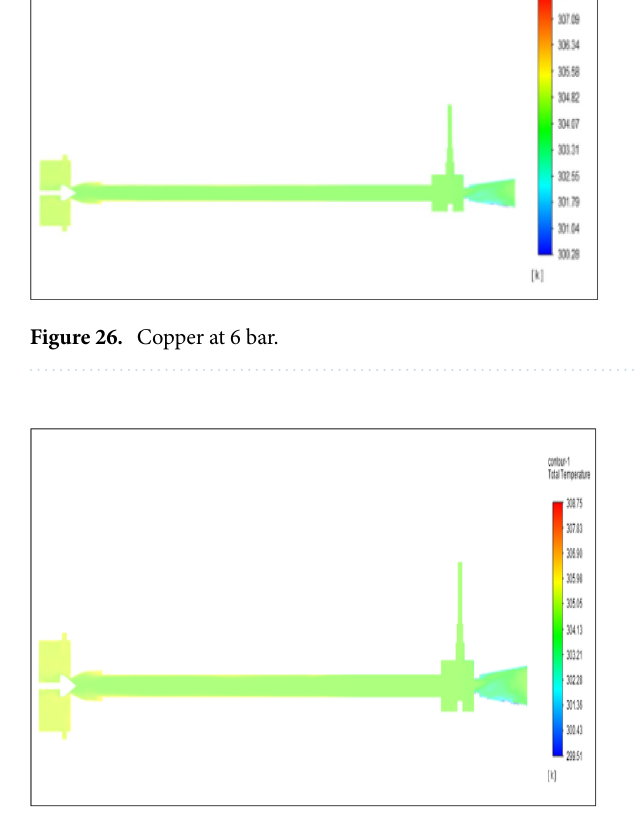
Figure 27. Stainless steel at 8 bar.